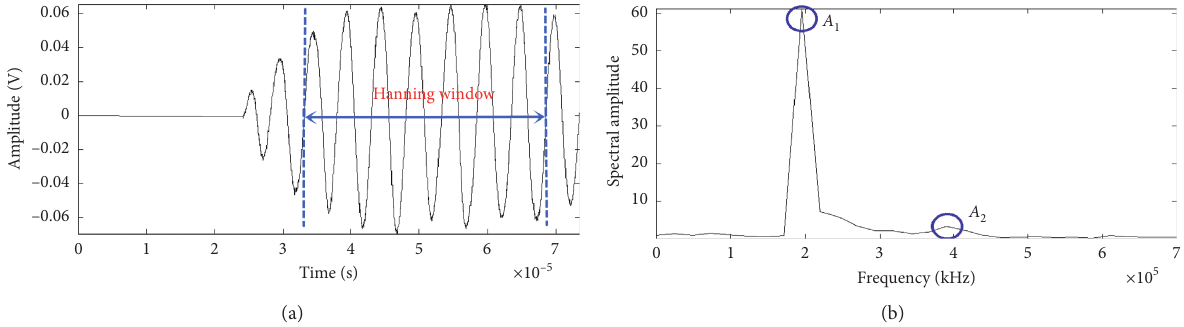
Figure 15: Example of the SHG test. (a) Time-domain signal. (b) Frequency-domain signal.